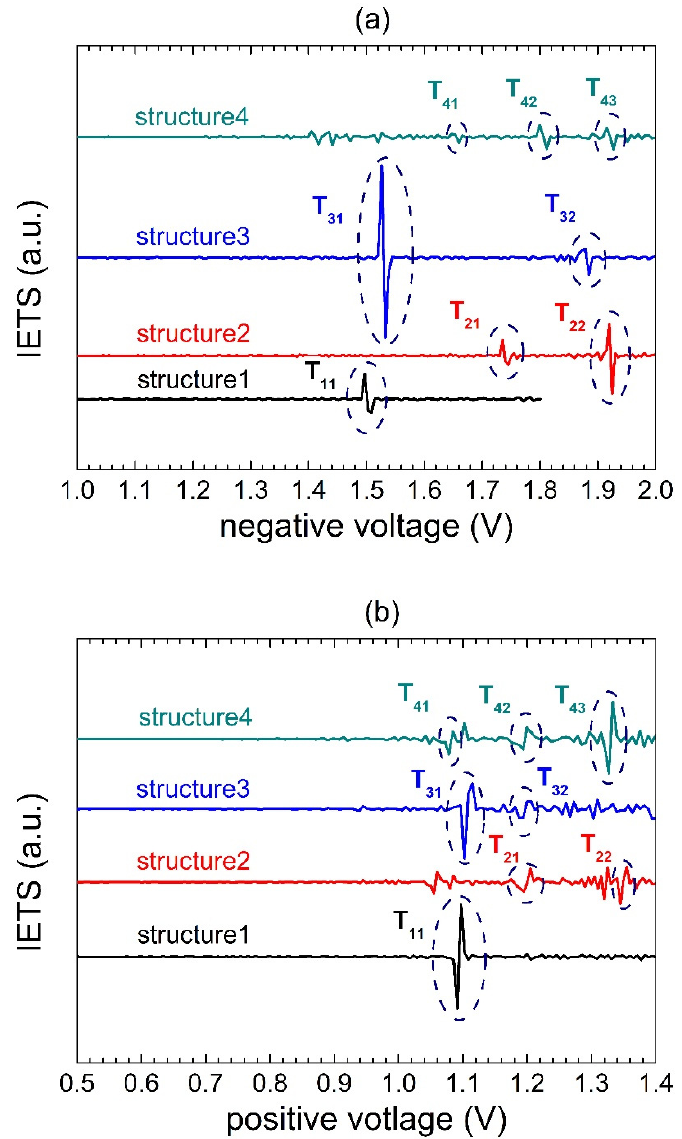
Figure 4. IETS signal of Al/SiO 2 /n++ Si structures for the negative ( a ) and positive ( b ) voltages. It has been shown [22] that positions of the peak-to-valley and valley-to-peak signals are related to the position x t of traps within the dielectric (the effective electrical distance from the oxide/metal gate interface) and the relative energy of the deep trap level E t = qV t above the Fermi level at the zero bias